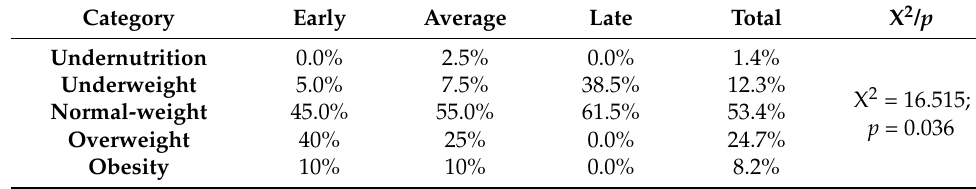
Table 5. Distribution (%) according to BMI classification by biological maturation